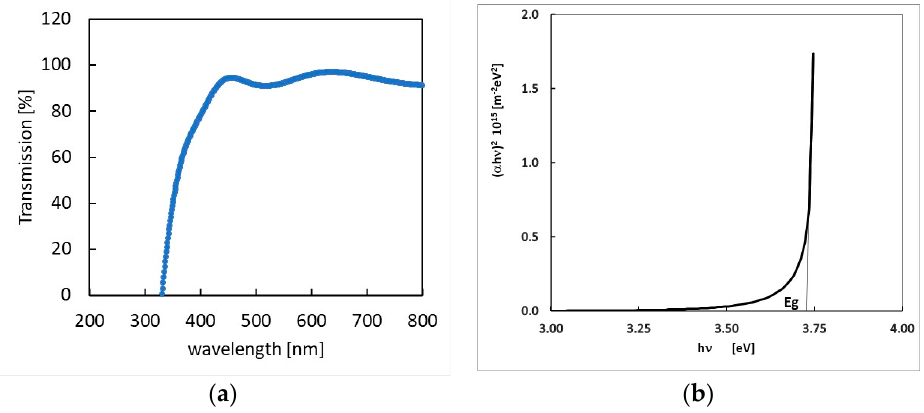
Figure 4. ( a )—optical transmission spectrum of the In 2 O 3-x 500 nm thick sample; ( b )—function (𝛼ℎ𝜈) (cid:2870) 𝑣𝑠 ℎ𝜈 plot and linear fi t used to determine the forbidden gap. ( α h ν ) 2 vs h ν plot and linear fit used to determine the forbidden